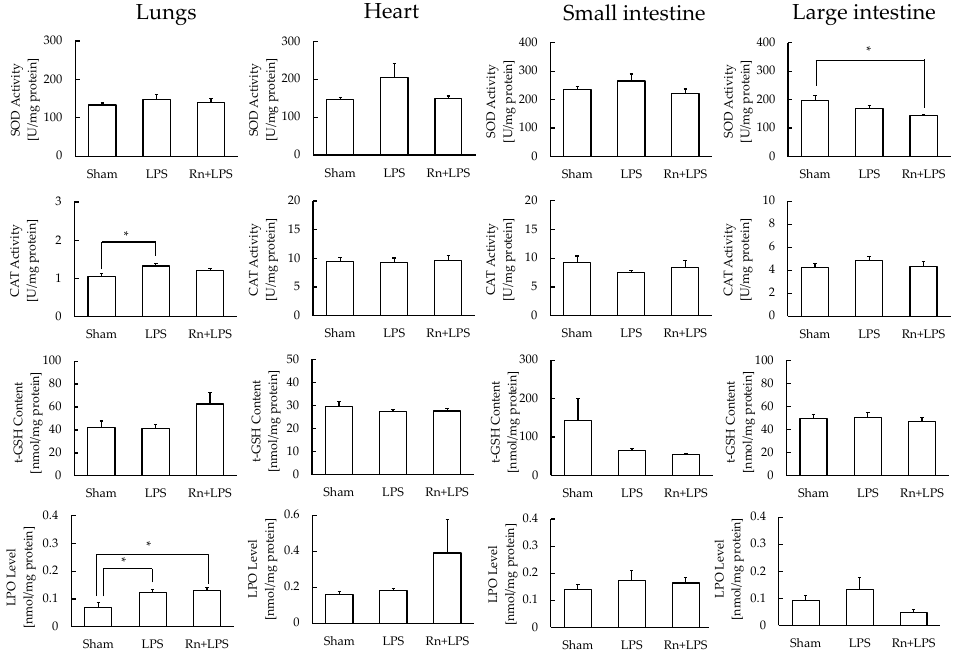
Figure 5. Effect of radon (Rn) inhalation on oxidative stress associated with lipopolysaccharide (LPS) administration in the lungs, heart, small intestine, and large intestine. The results are presented as the mean ± SEM. N = 6–7; * p < 0.05; all experiments were conducted once; * p < 0.05; sham, mouse group without any treatment; sham + LPS, mouse group that inhaled sham followed by LPS (1 mg/kg body weight); Rn + LPS, mouse group that inhaled radon (2000 Bq/m 3 ) followed by LPS (1 mg/kg body weight); SOD, superoxide dismutase; CAT, catalase; GSH, glutathione; LPO, lipid per- oxide.